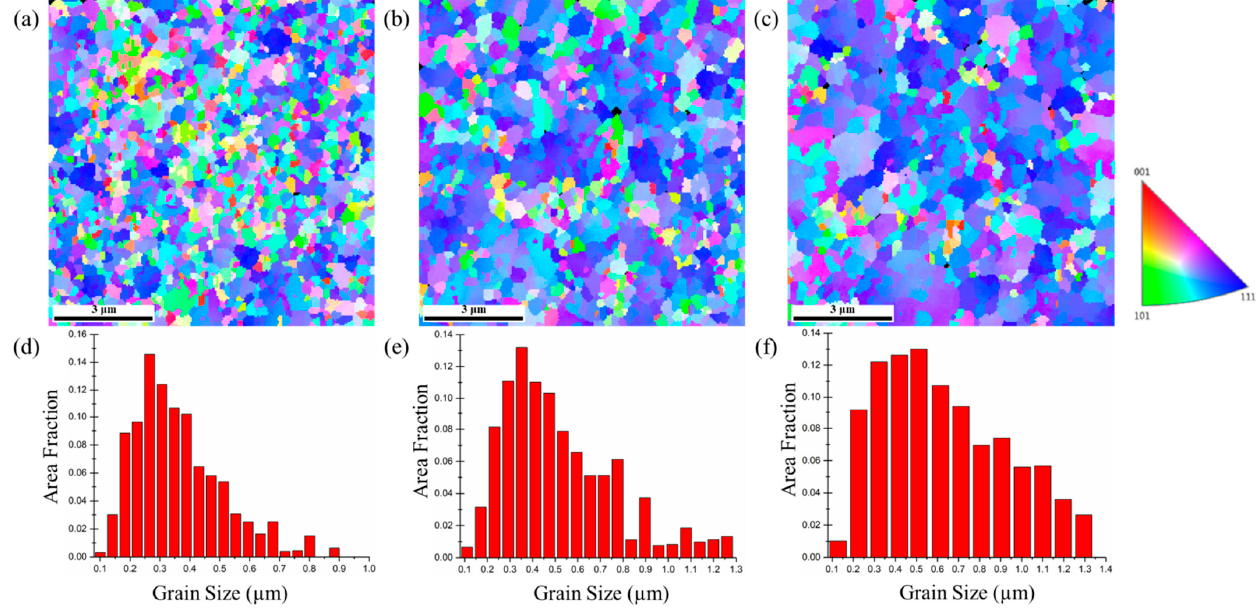
Figure 6. Plan-view EBSD micrographs and grain size distributions of the 10- µ m thick nt-Cu foils electroplated with different concentrations of Cu 2+ : ( a , d ) 0.3 M; ( b , e ) 0.5 M; ( c , f ) 0.8 M, respectively.